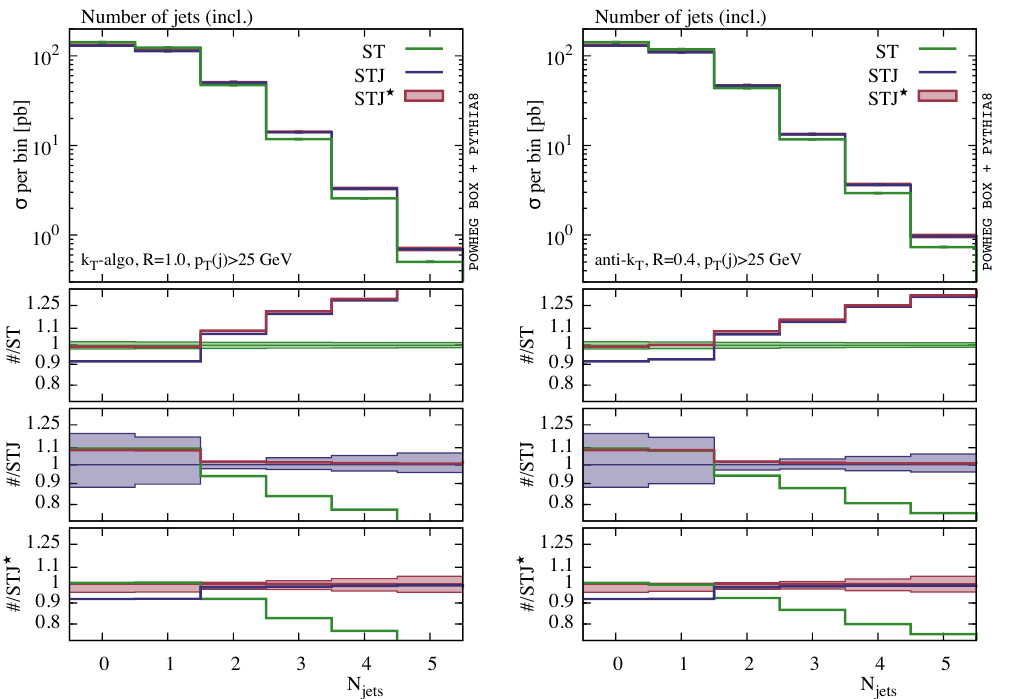
Figure 3 . Inclusive jet cross sections in t -channel single-top production, with a jet transverse momentum threshold of 25 GeV. The left-hand plot shows predictions for jets de(cid:12)ned according to the k t clustering algorithm with radius parameter R = 1, while the right-hand plot gives the analogous predictions for the case of the anti- k t algorithm with R = 0 : 4. As in (cid:12)gure 2 we show in green, blue and red, predictions from the ST , STJ and STJ ? simulations